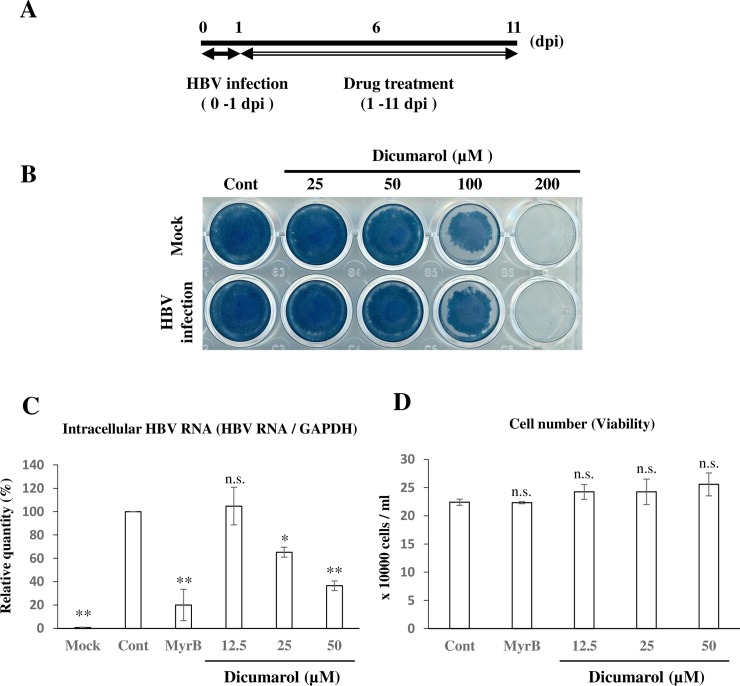
Dicumarol inhibits HBV replication in NmcHepG2 cells.(A) Scheme for infection and drug treatment. NmcHepG2 cells were infected with HBV in the absence or presence of MyrB at 0–1 dpi. At 1 dpi, the virus-containing medium was removed and a dicumarol-containing medium was added. Every 2 days, the medium was changed and samples were collected at 11 dpi. (B) Cell toxicity was examined by amido black staining. (C) At 11 dpi, RNA was quantified by qPCR. Mock: uninfected, MyrB: Myrcludex B, cont: mutant MyrB. (D) Cell viability was confirmed by counting the cell number. Data are means ± SE of replicates from three independent experiments and were analyzed by the t-test: *P < 0.05, **P < 0.01.